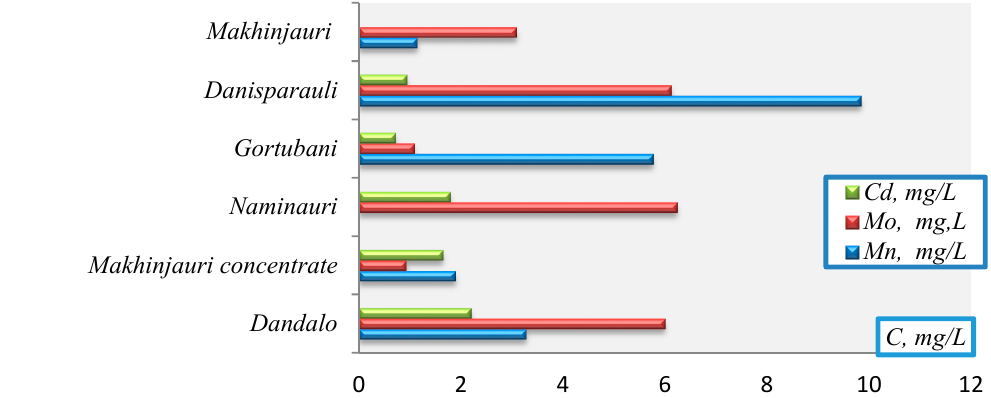
Figure 12. The content of Cd, Mo and Mn in the mineral waters.